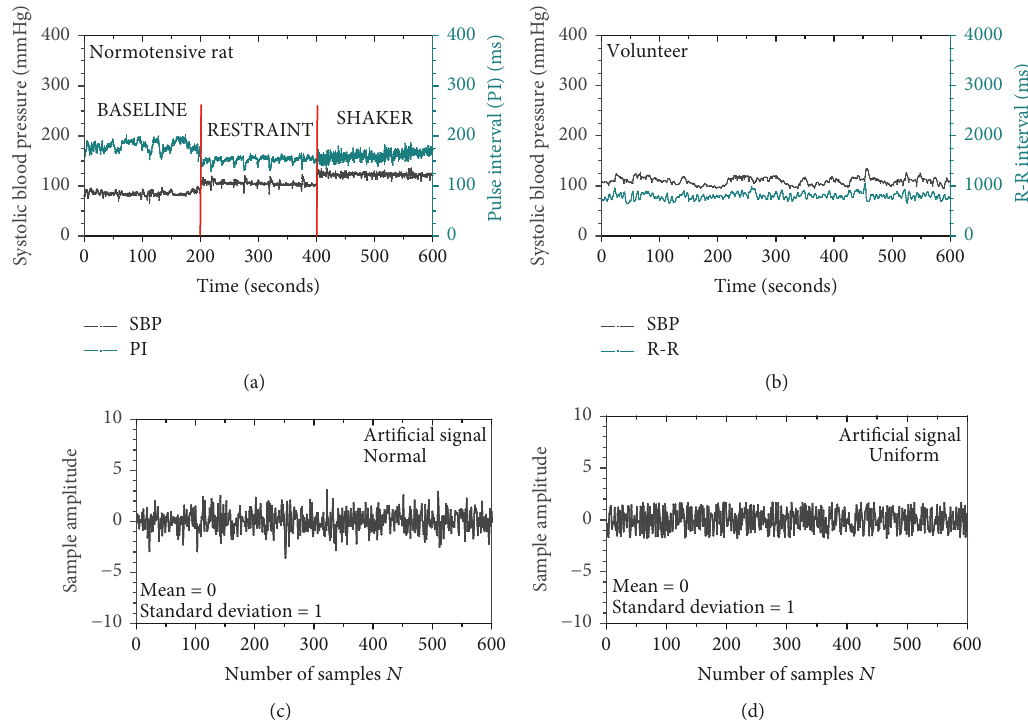
Figure 1: Examples of real cardiovascular signals and of artificially generated signals. (a) SBP signal (gray) and PI signal (green) recorded from a rat at baseline condition, exposed to restraint stress and exposed to shaker stress. (b) SBP (gray) and R-R (green) signals recorded from a healthy volunteer. (c, d) Artificially generated signals with zero mean and standard deviation equal to 1; normal distribution (c) and uniform distribution